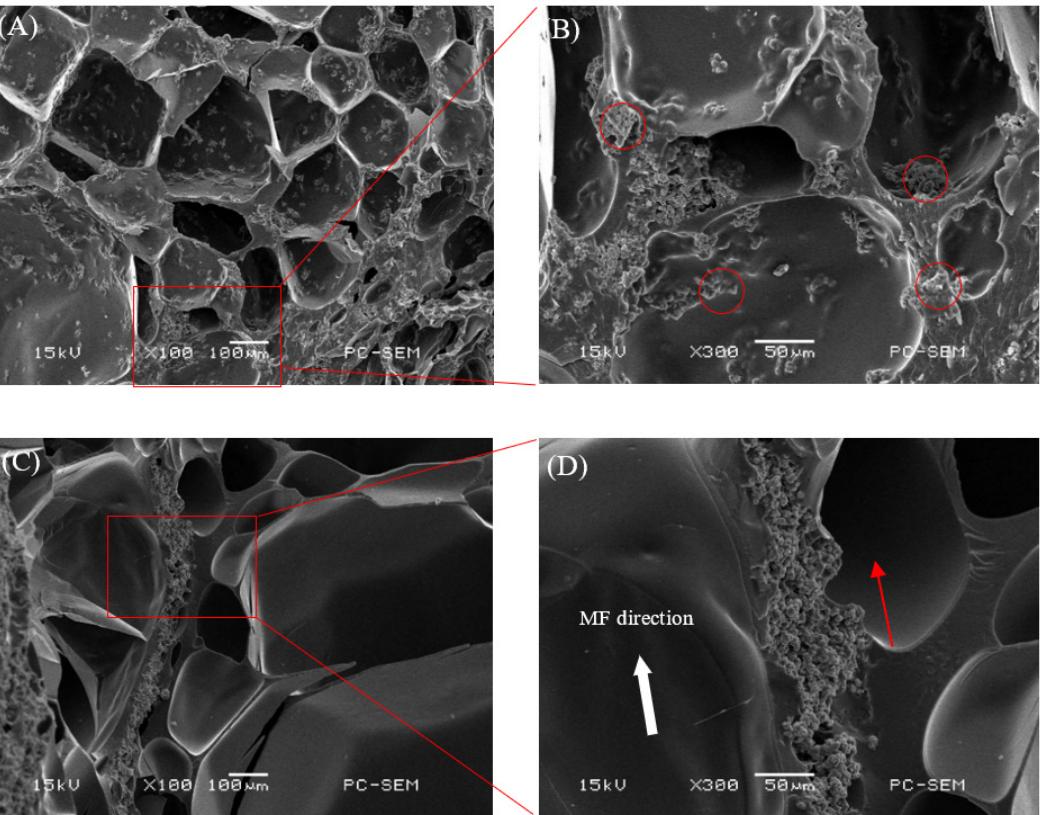
Figure 1. SEM images of cross-section surfaces of the freeze-dried magnetic hydrogels with 2 vol% CI. ( A ) isotropic sample; ( B ) magnification of the red rectangular area in ( A ); ( C ) anisotropic sample; ( D ) magnification of the red rectangular area in ( C ).